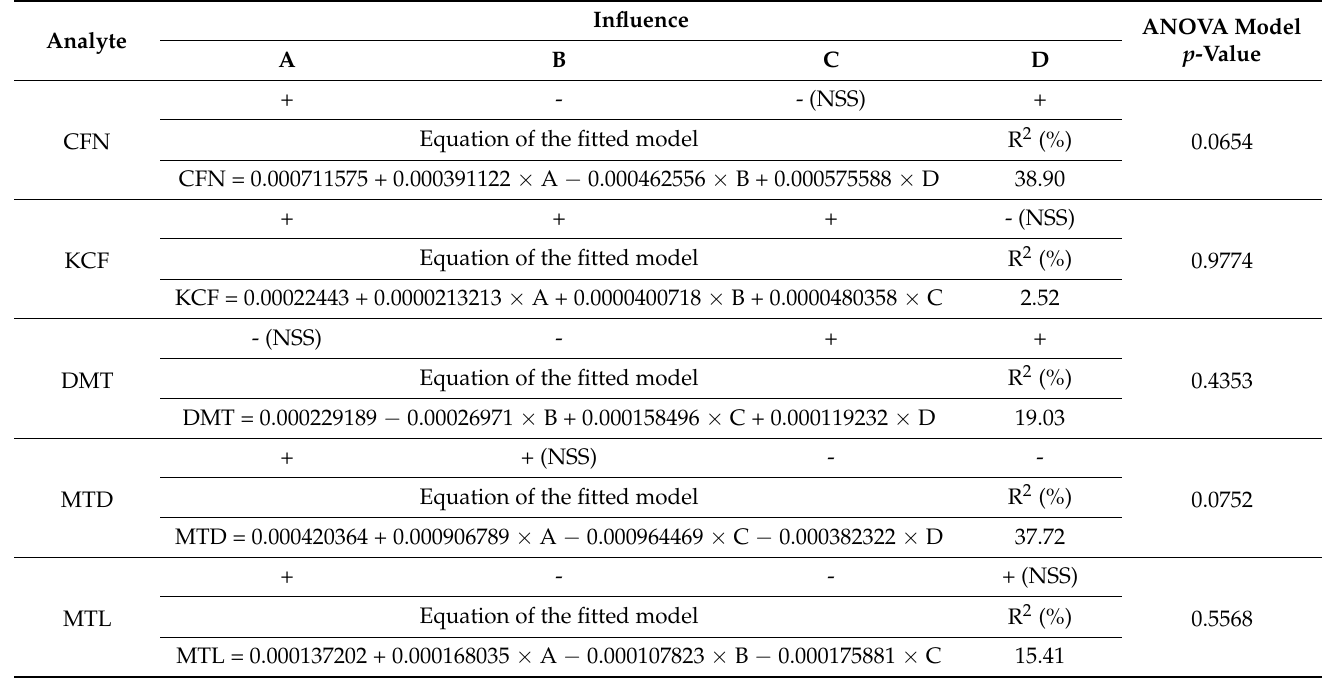
Table 5. Summary of the multifactorial multiple regression analysis for the analytes under study and their experimental variables, using CLPHMA, and mechanical agitation for extraction.